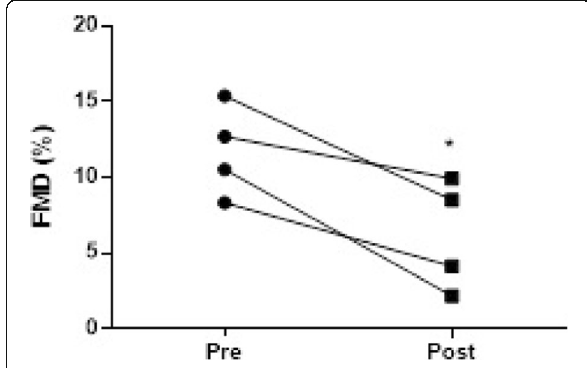
Fig. 1 (abstract P161). Effect of exercise training (pre and post 12- weeks) in endothelial function measured by flow-mediated